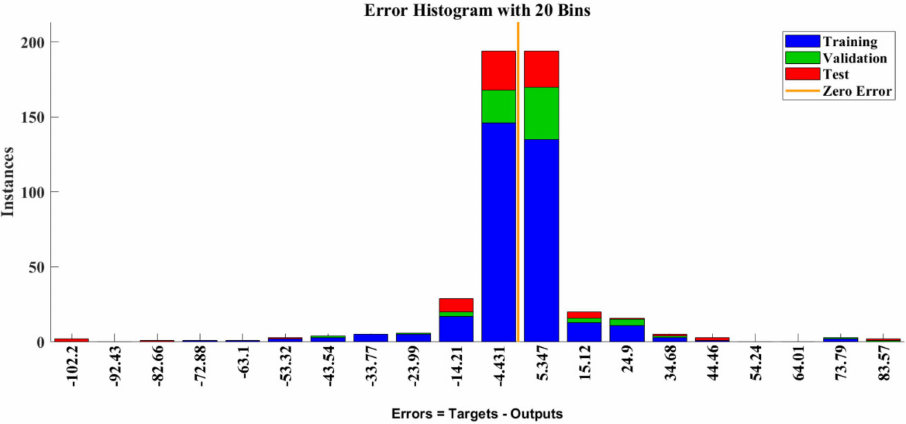
Figure 9. Error histogram plot of training, validation, and testing